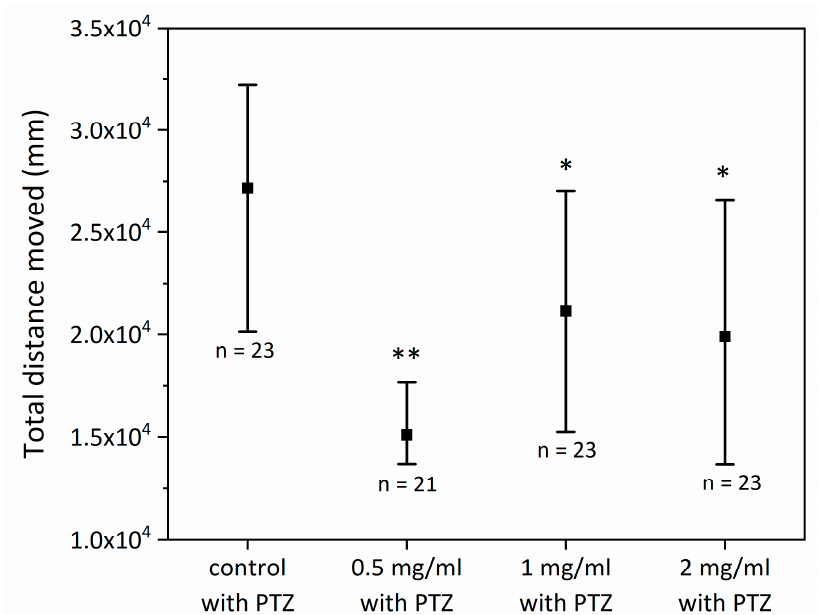
Figure 3. Comparison of different groups exposed to PTZ in short-term exposure protocol. * p < 0.05 compared to control group; ** p < 0.0001 compared to control.